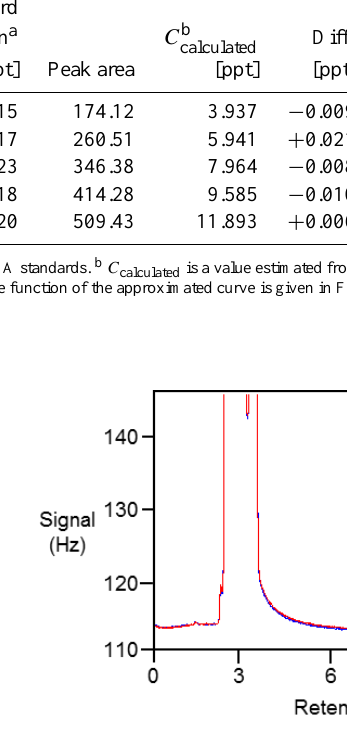
Fig. 5. Chromatogram of a working standard (CC315007, red) over- Figure 5 Chromatogram of a working standard (CC315007, red) overlaid on one of the five 2 laid on one of the five WMO cylinders (FB03443,